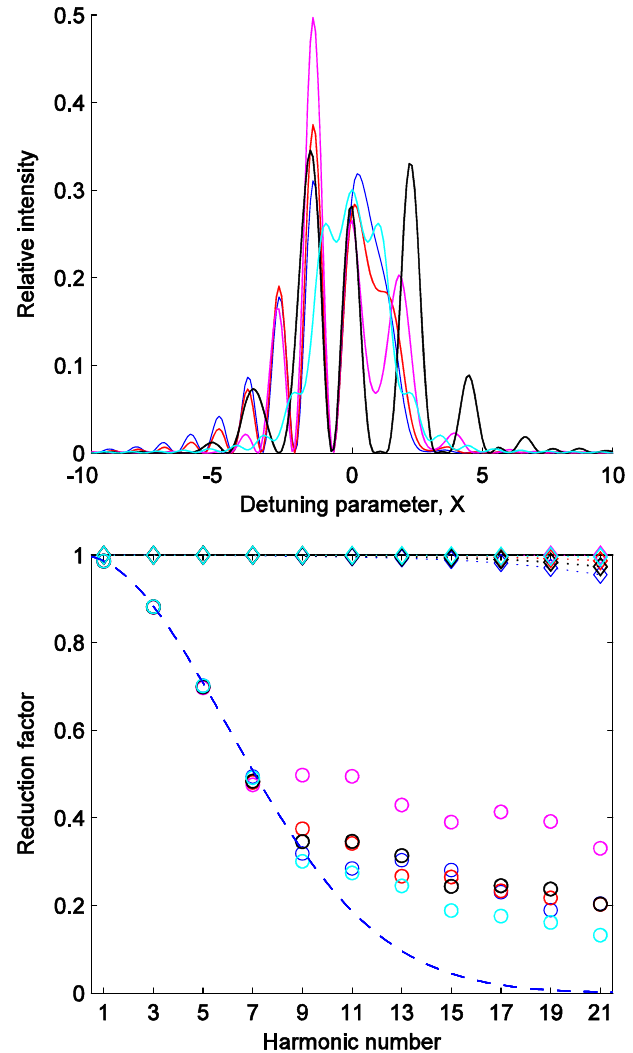
FIG. 13. On-axis single-electron brightness spectra for the 9th harmonic (upper) and reduction factors (lower) for peak (circles) and integrated (diamonds) brightness for the four cases of systematic phase errors shown in Fig. 3, using the corresponding colors. The dashed line is Eq. (1) with the relevant rms phase ¼ 6 : 7 (cid:2) error, (cid:1) ’